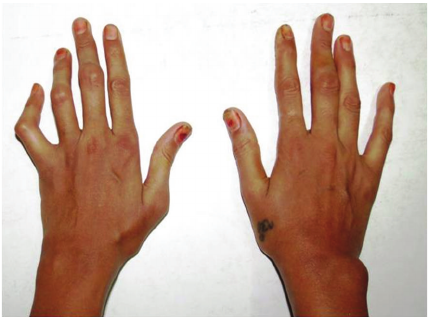
Figure 3: Showing presence of nodules at the right wrist joint on lateral aspect.